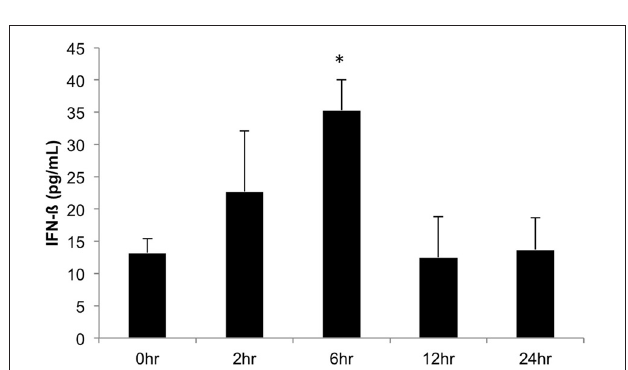
FIGURE 9 | IFN- β production in human bronchial epithelial cells over time in response to Alternaria alternata spores. BEAS-2B human bronchial epithelial cells were challenge with 1 × 10 5 A. alternata spores and INF- β levels were assayed by ELISA. ∗ p ≤ 0 . 002 vs.